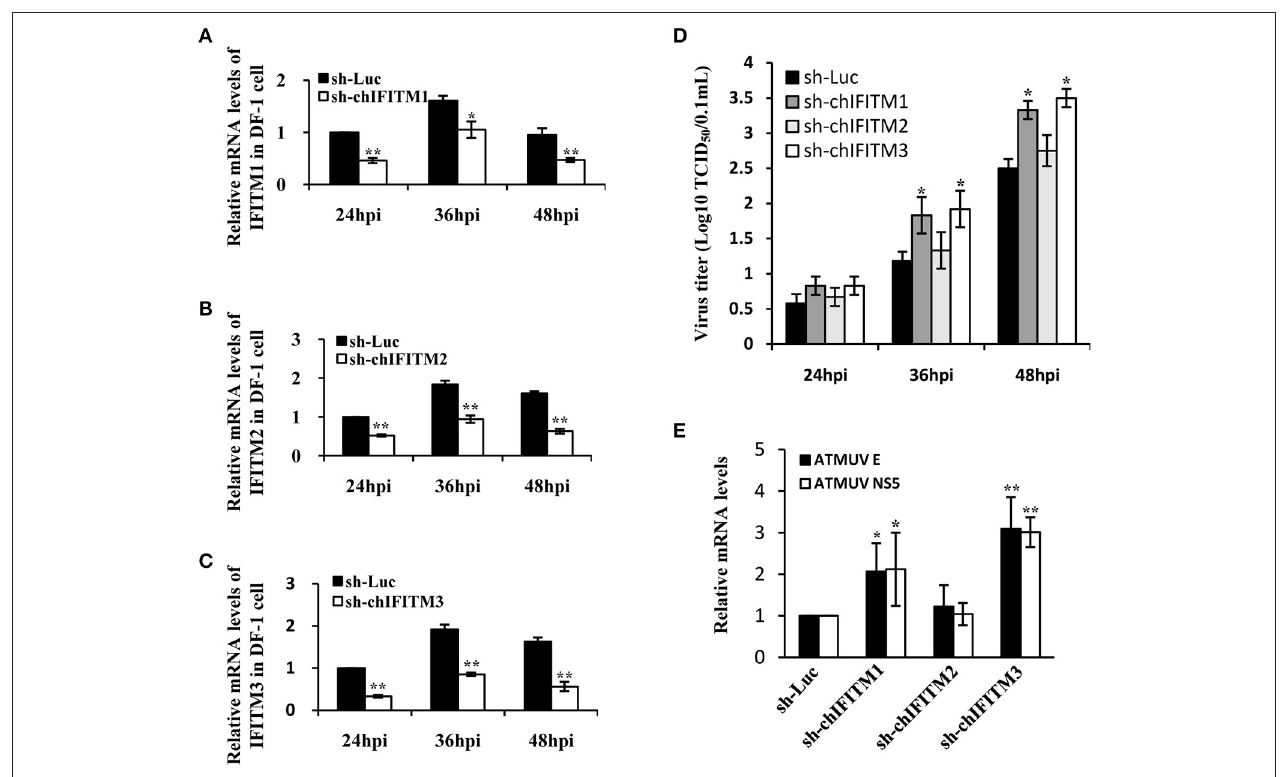
FIGURE 5 | Knockdown of endogenous IFITM1 and IFITM3 significantly promotes ATMUV replication in DF-1 cells. DF-1 cell lines stably expressing specific shRNAs targeting chicken IFITM1, 2, 3 or luciferase control were infected with or without ATMUV at a MOI of 1.0 and harvested at indicated time points of 24, 36, and 48 hpi. (A–C) qRT-PCR was performed to measure interference efficiency of the shRNAs. (D) Viral load in cell culture supernatants was titrated via TCID 50 assay in DEF cells. (E) DF-1 cell lines expressing specific IFITM-shRNA were infected with ATMUV and harvested at 36 hpi, followed by qRT-PCR assay to detect mRNA expression of viral genes. The mRNA levels were normalized to the endogenous β -actin level and the expression in ATMUV infected DF-1 cell line expressing luc-shRNA control was set to 1.0. mRNA expression in DF-1 cells expressing specific IFITM-shRNA was compared to that in control cells expressing luc-shRNA. Plotted are the average results from three independent experiments (means ± SD ). Statistical significance was determined by one tail Student’s t -test analysis. * P < 0.05, ** P < 0.01.